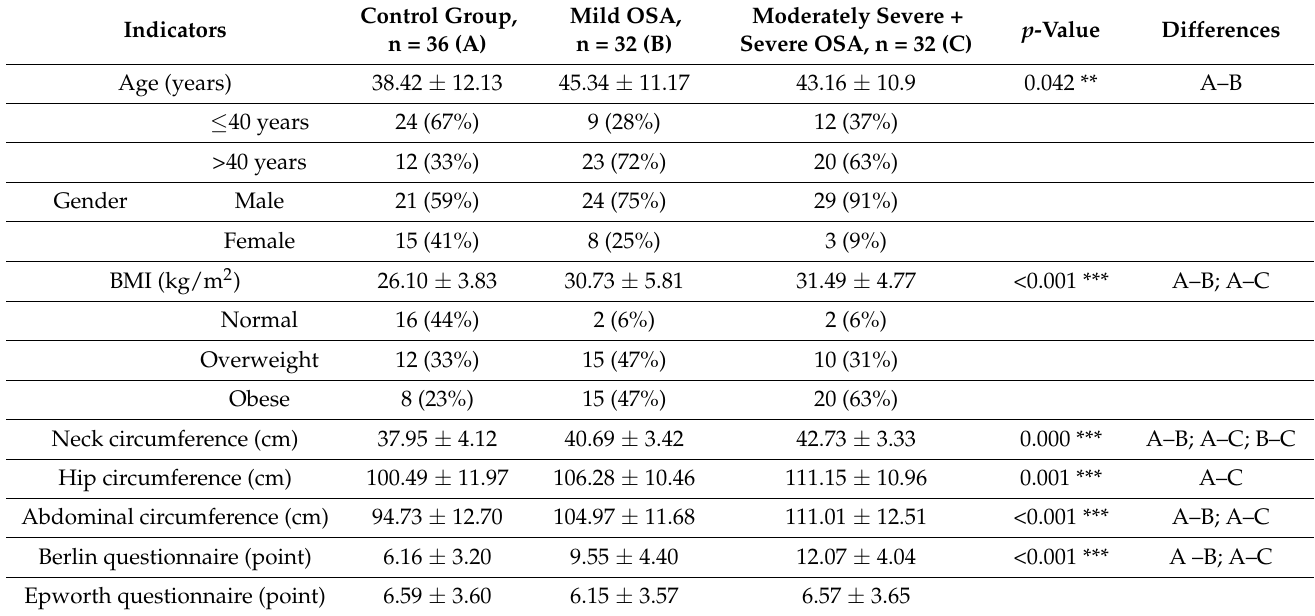
Table 1. Distribution of anthropometric and demographic parameters and the results of the Berlin and Epworth questionnaires in the study groups. The parameters show the mean ± SD values. Case numbers and % distribution are indicated in the age, gender and BMI subgroups. *** indicates significant difference at the p < 0.01 level, while ** indicates significant difference at the p < 0.05 level. OSA: obstructive sleep apnoea. BMI: body mass